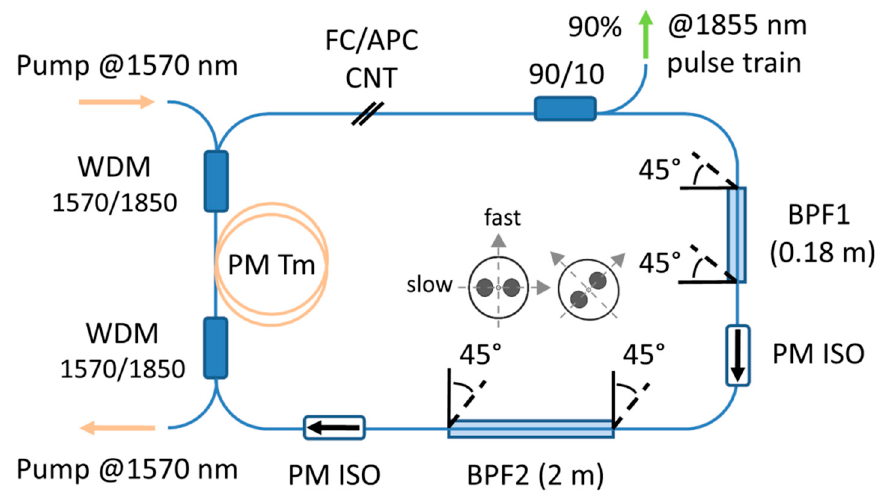
Figure 1. The all-PM mode-locked Tm-doped fiber laser: CNT-carbon nanotubes in FC/APC connectors module, BPF1 + PM ISO-‘wide’-bandwidth Lyot filter, BPF2 + PM ISO-‘narrow’-bandwidth Lyot filter, WDM 1570/1850-wavelength division multiplexing coupler.